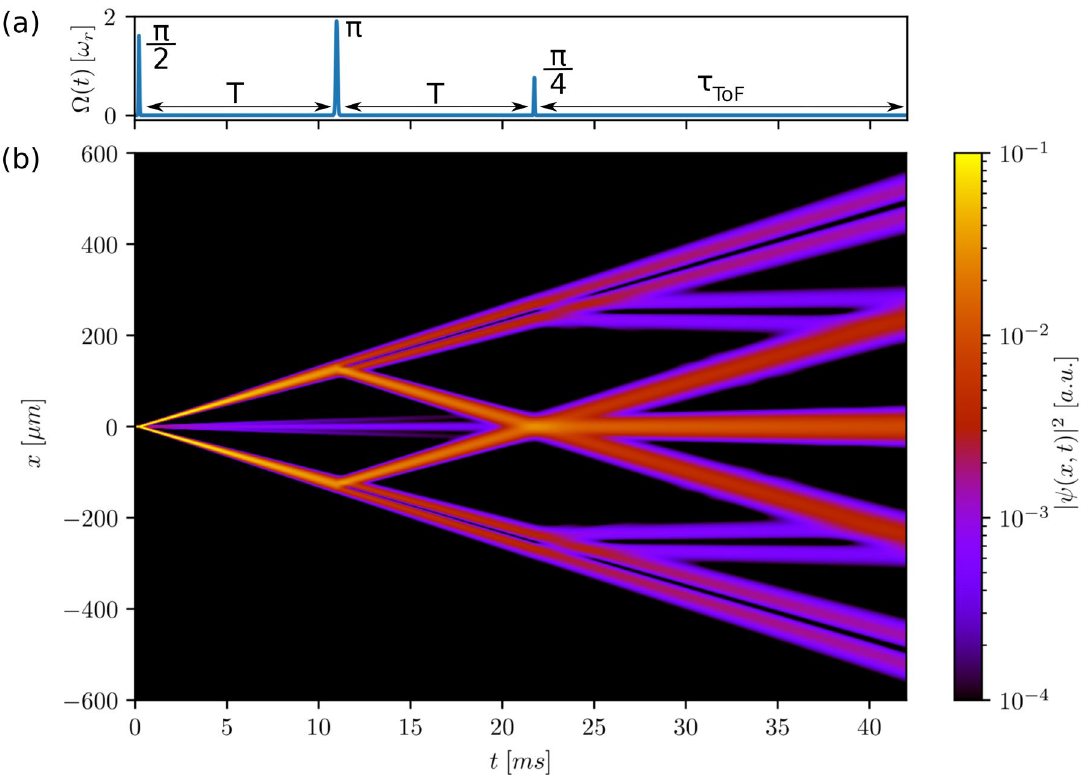
Figure 4. ( a ) Rabi frequency �( t ) over time of a symmetric double Bragg interferometer according to Eq. (2). 2 is plotted for an initial momentum width of σ 0.1 (cid:31) k. ψ( x , t ) ( b ) The corresponding probability density p = | | 50 µ s, respectively. The 25 µ s and τ The timings of the Gaussian splitter and mirror pulses are set to τ bs m = = corresponding Rabi frequencies are found by optimising the desired population transfer. The first π 2 pulse corresponds to a 2 (cid:31) k transfer in two directions, realised by two counter-propagating optical lattices which results in a 4 (cid:31) k separation between the two interferometer arms. The mirror pulse is a 4 (cid:31) k Bragg transition 1.9 ω 2 (cid:31) k 2 (cid:31) k with a Rabi frequency of (cid:31) . The r such that both arms make a transition from | ± = � → | ∓ � 2 (cid:31) k 0 (cid:31) k last recombination pulse now realises a 50 : 50 split of the upper trajectory to and and the lower | − � | � 2 (cid:31) k 0 (cid:31) k 2 (cid:31) k 0 (cid:31) k trajectory to and . This leads to a final population of 25% in the ports and 50% in the | + � | � | ± � | � 10 ms with a final time of flight after the exit beam splitter port. The separation time between the pulses is T = 20 ms. Due to velocity selectivity of the Bragg pulses and a non-ideal fidelity of the initial beam of τ ToF = splitter pulse, several parasitic interferometers can be